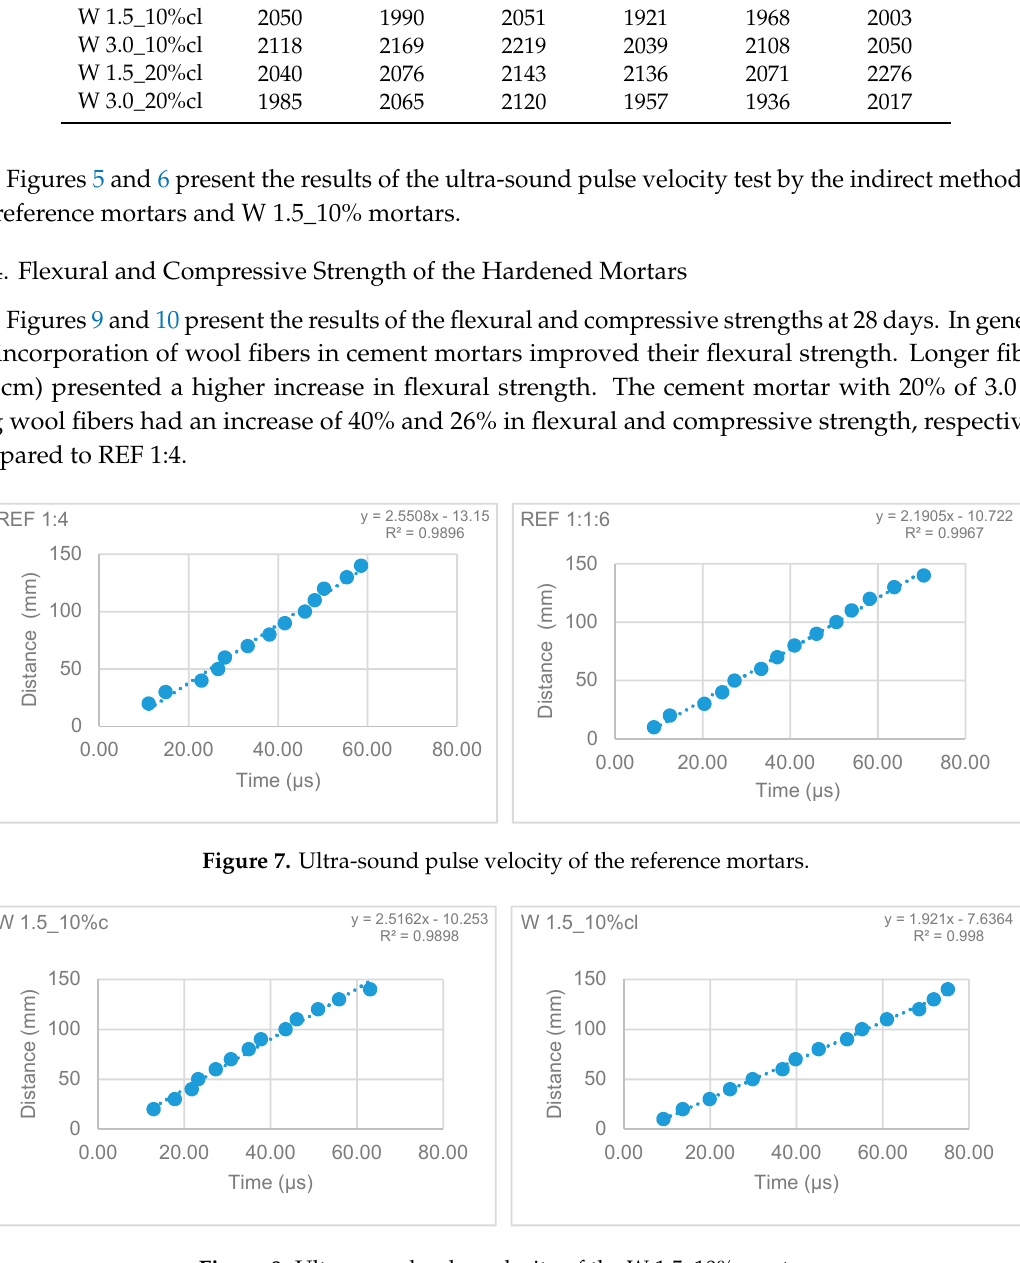
Table 5. Ultra-sound pulse velocity of the mortars tested. Mortar